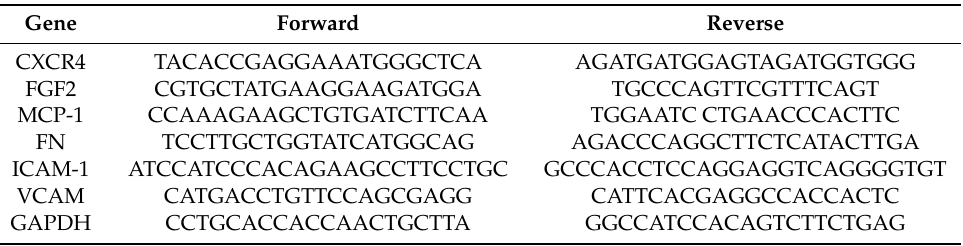
Table 1. Primer sequence of chemokines and adhesion molecules (migration genes).